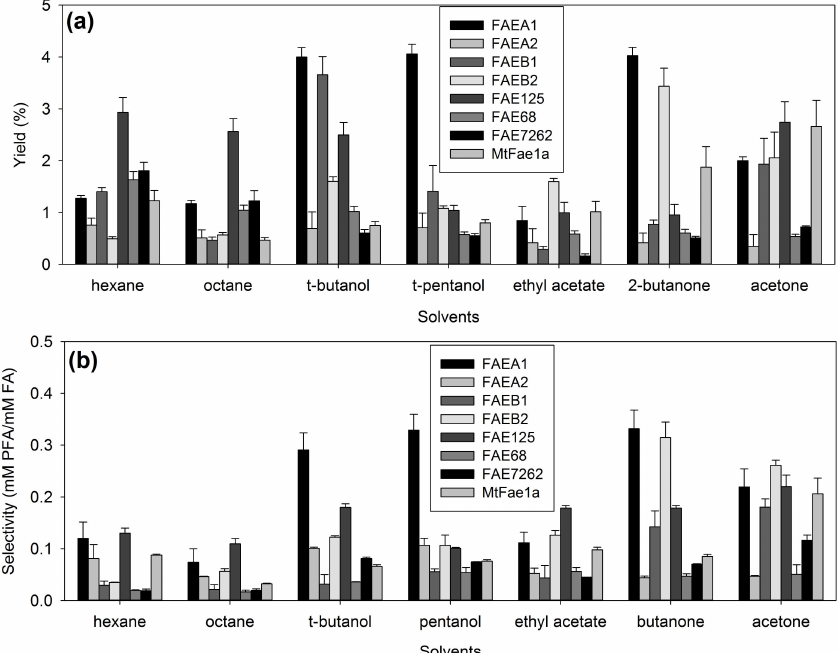
Figure 2. Effect of organic solvents on the synthesis of arabinose ferulate from the obtained CLEAs. ( a ) Product yield (%), ( b )